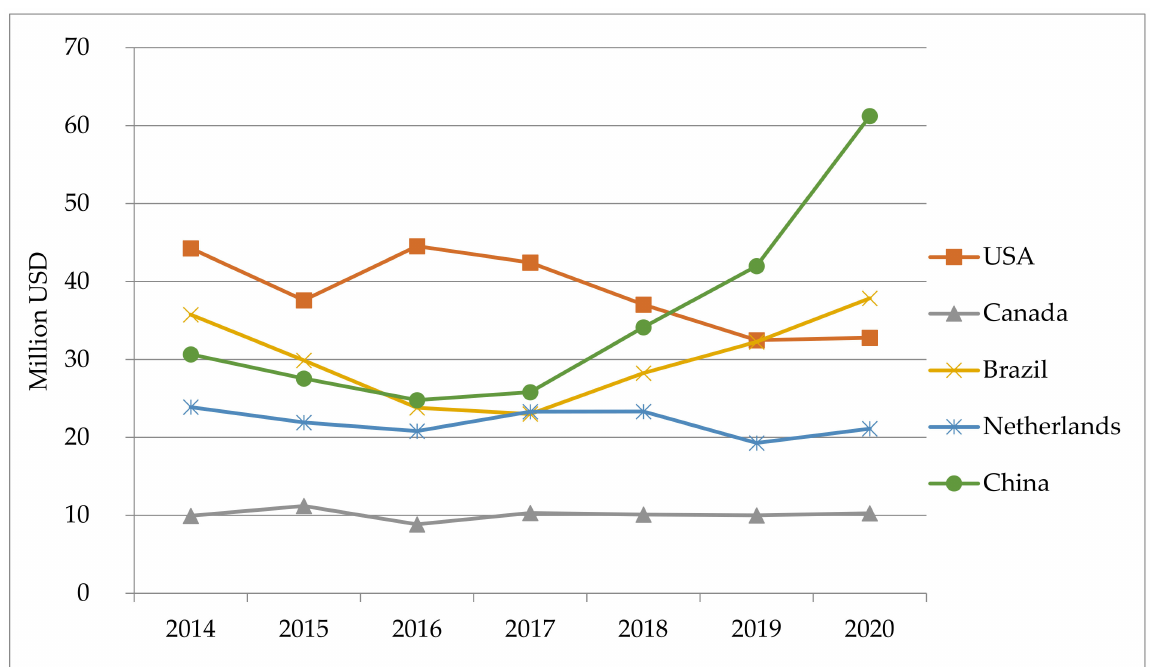
Figure 7. Value of imported bovine semen in selected countries in the period of 2014–2020, in